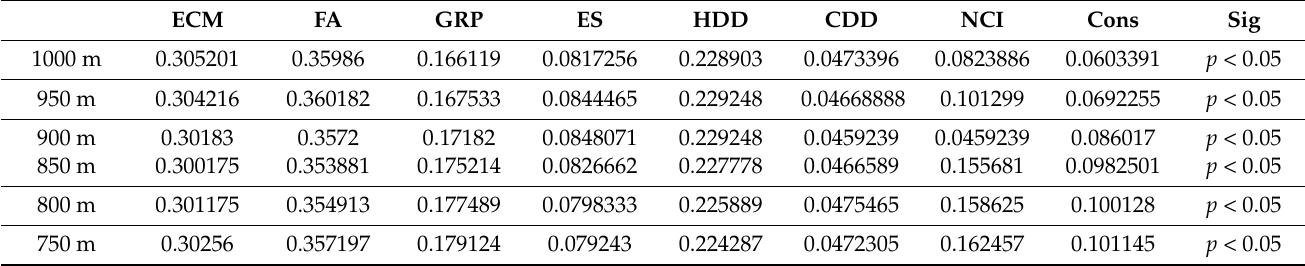
Table A2. A regression equation result for all 20 models by